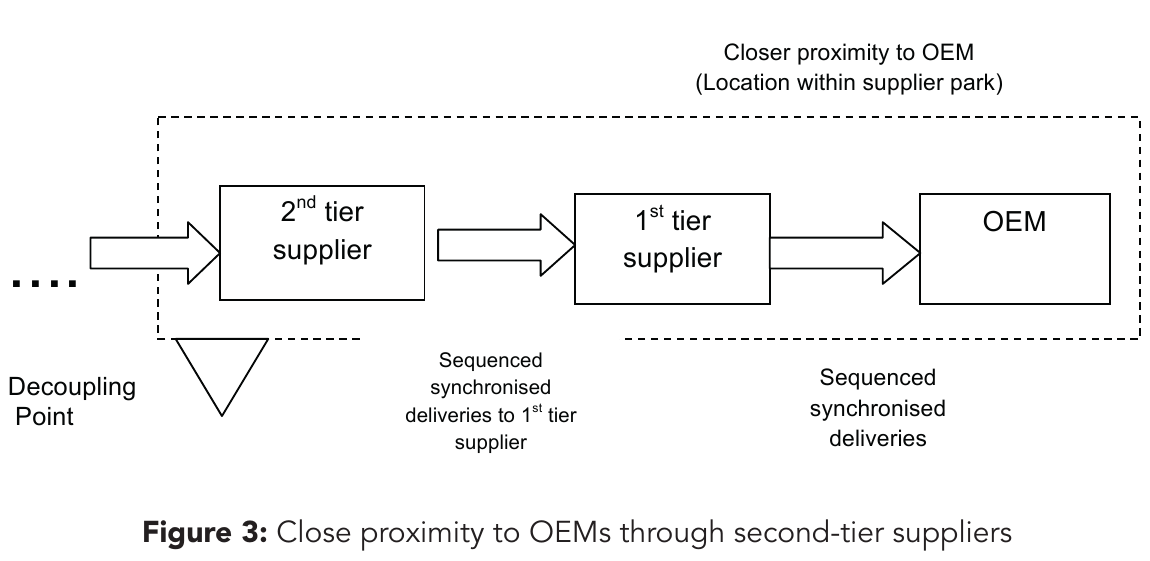
Figure 3: Close proximity to OEMs through second-tier suppliers